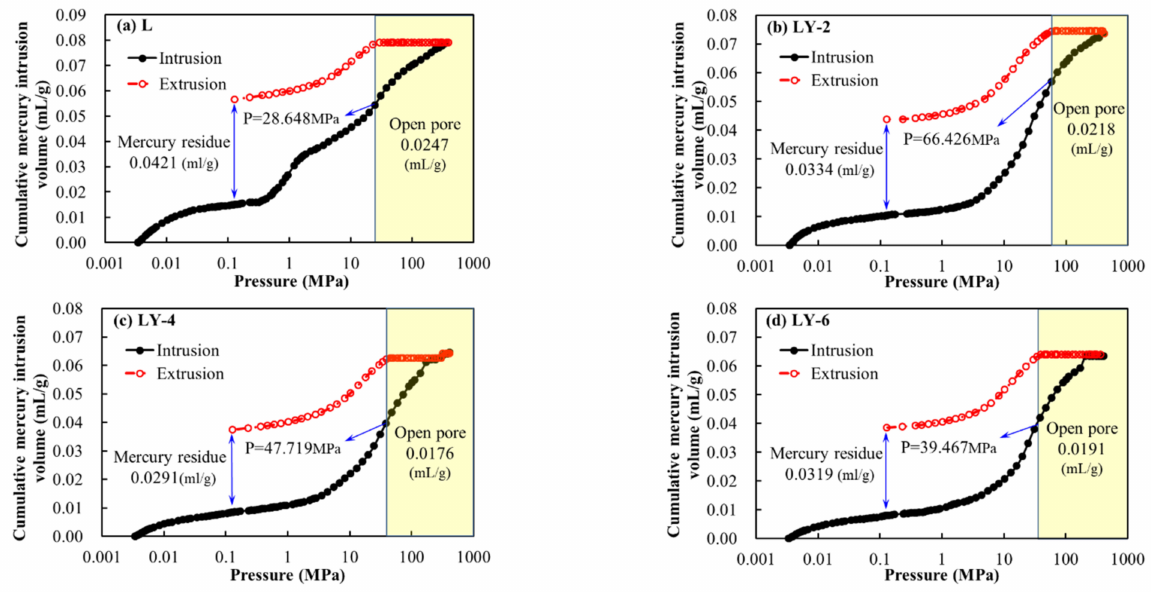
Figure 8. Mercury intrusion and extrusion curves of samples: ( a ) L; ( b ) LY-2; ( c ) LY-4; ( d )